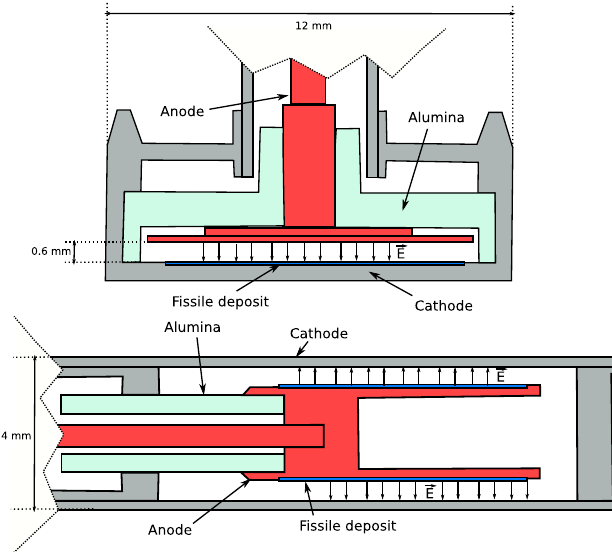
Fig. 3. Two example of flat (left) and cylindrical (right) fission chamber designs built by the CEA fission chamber